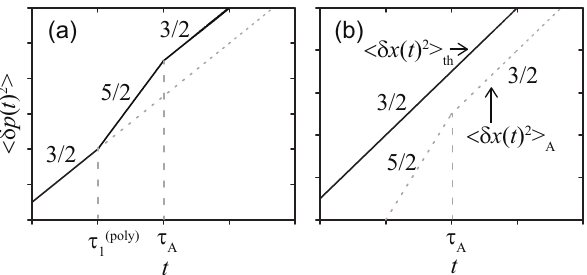
(cid:10) (cid:11) Figure 4. Sketches of MSDs δ p ( t ) 2 for the Rouse polymer in a viscous media at double-logarithmic scales. The active noise with ( a ) strong γ k B T / τ A < A or ( b ) weak γ k B T / τ A > A magnitude,